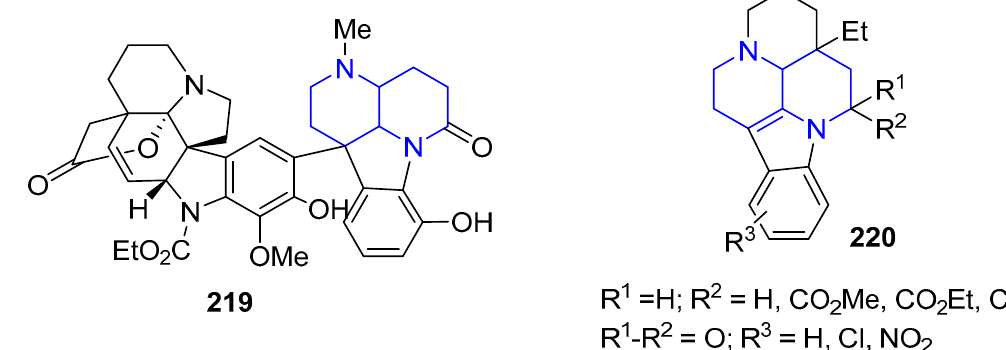
Figure 20. Fused 1,5-naphthyridines with hypotensive and pain-relieving activities.